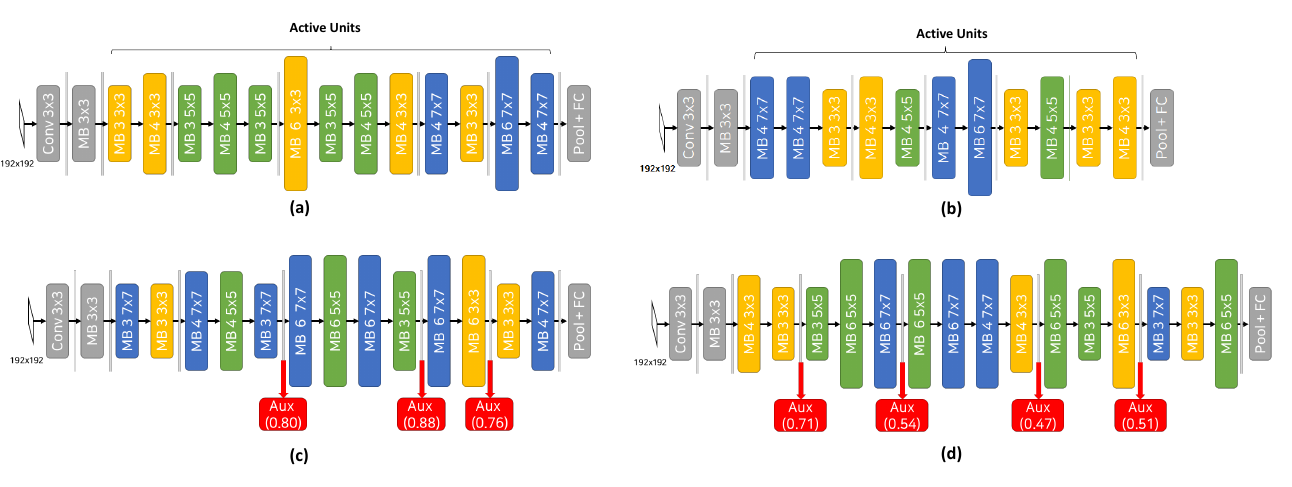
Figure 8. Examples of (near-)optimal CNNs obtained from OFA for Galaxy Note10+ ( a ) CPU and ( b ) GPU, and examples of (near-)optimal conditional CNNs obtained from CondNAS for Galaxy Note10+ ( c ) CPU and ( d )